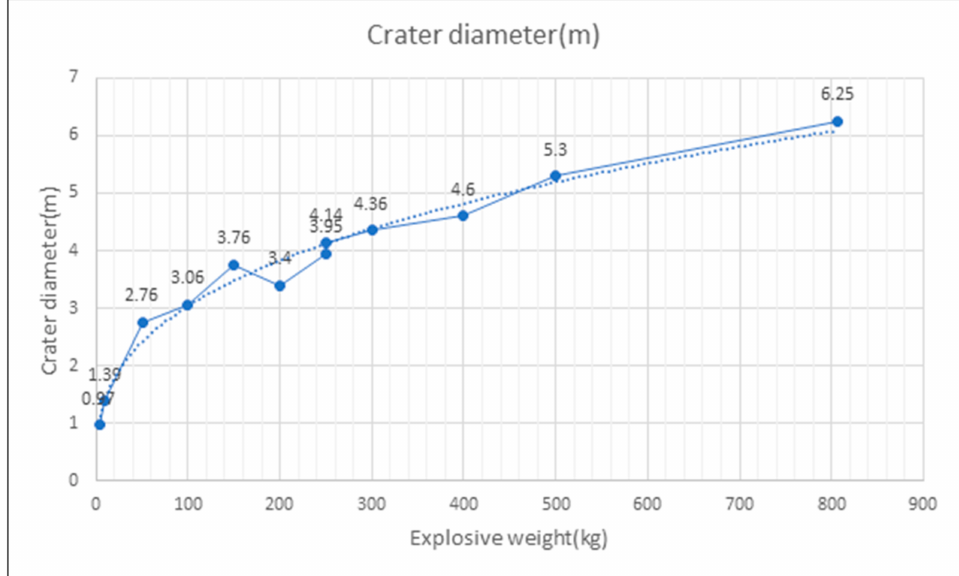
Figure 1. Crater Diameter by LS-DYNA